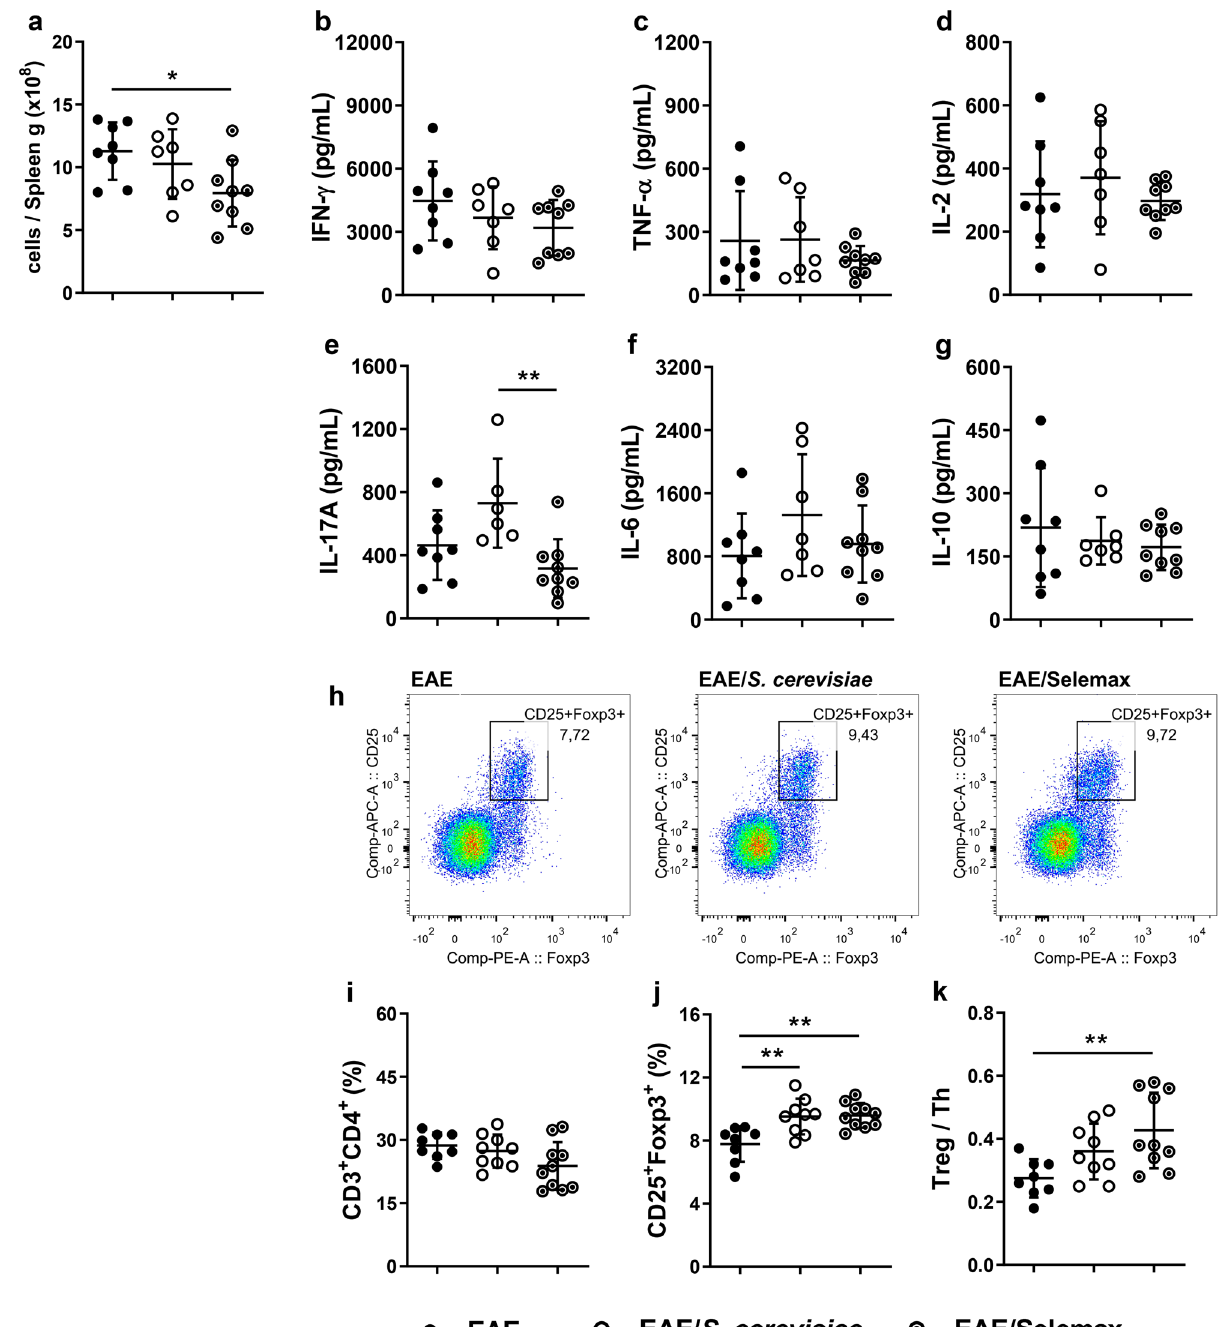
Figure 4. Effect of S. cerevisiae and Selemax on cytokine production by spleen and proportion of Tregs in inguinal lymph nodes. EAE mice received 14 oral doses of S. cerevisiae or Selemax. Total number of leukocytes from spleen adjusted per gram of tissue ( a ). Spleen cells (5 × 10 6 ) were stimulated with MOG 35-55 (20 µg/mL) for 48 h and the production of IFN-γ ( b ), TNF-α ( c ), IL-2 ( d ), IL-17A ( e ), IL-6 ( f ) and IL-10 ( g ) were assessed in the supernatants. Representative gating strategy to assess regulatory T cells (Treg - CD25 + Foxp3 + ) in inguinal lymph nodes ( h ). Total cells from inguinal lymph nodes were collected and analyzed by flow cytometry to determine the proportion of T helper cells (Th - CD3 + CD4 + ) ( i ) and Treg in total Th cells ( j ). The proportion of T subsets was used to calculate the ratio between Treg and Th cells ( k ). Statistical analysis was performed by one-way ANOVA and subsequent Tukey’s test. All data were expressed as the mean ± SD and statistical differences were represented by * p < 0.05 and ** p < 0.01. Two independent experiments were combined, n = 7–10 mice/group. The graphs were created using GraphPad Prism v.8.0.2, flow cytometry images were created using FlowJo 10.7.1 and image was modified with Adobe Photoshop